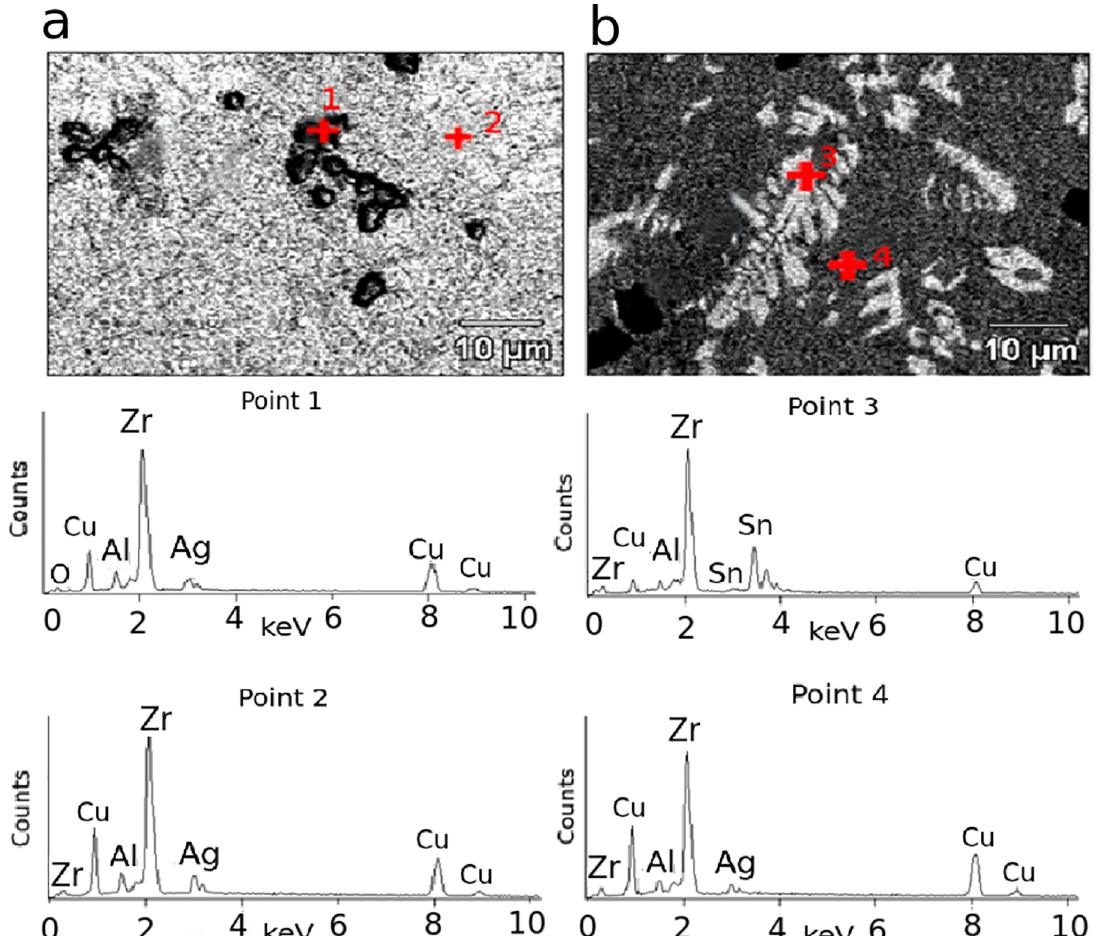
Zr Al Ag suction-casted sample, in b: Cu 42 42 8 8